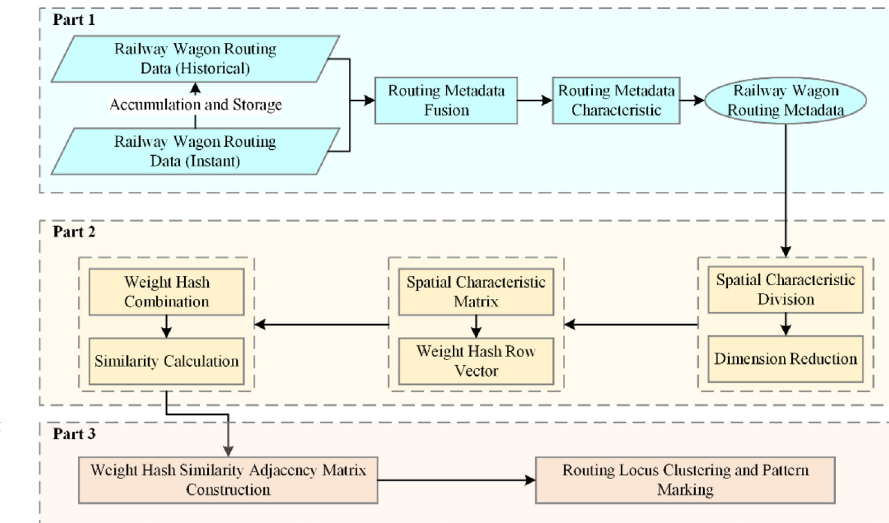
Figure 4 points out the relationship of the characteristics in the routing metadata.